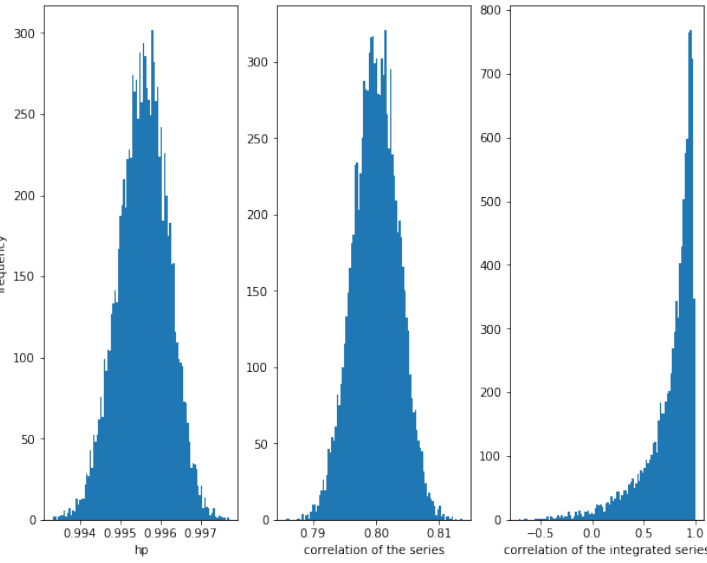
Figure 7. Histogram of the relationships in series with a Gaussian copula relationship with ρ = 0.8. HP is very high, correlation is around 0.8 as expected and the correlation of the integrated series is often high, but there is a lot of